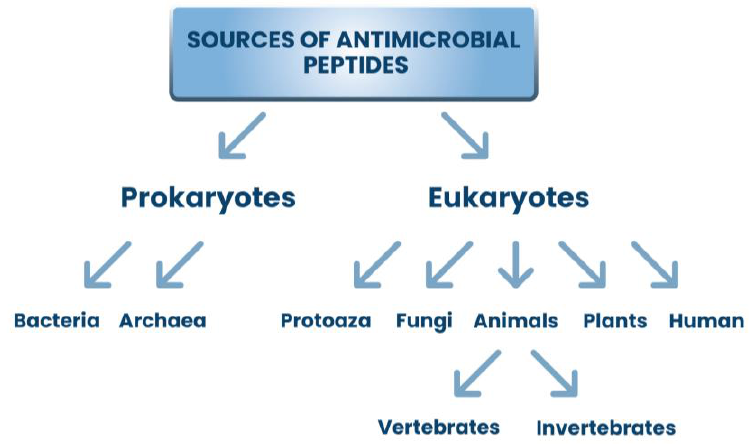
Figure 7. Sources of antimicrobial peptides.